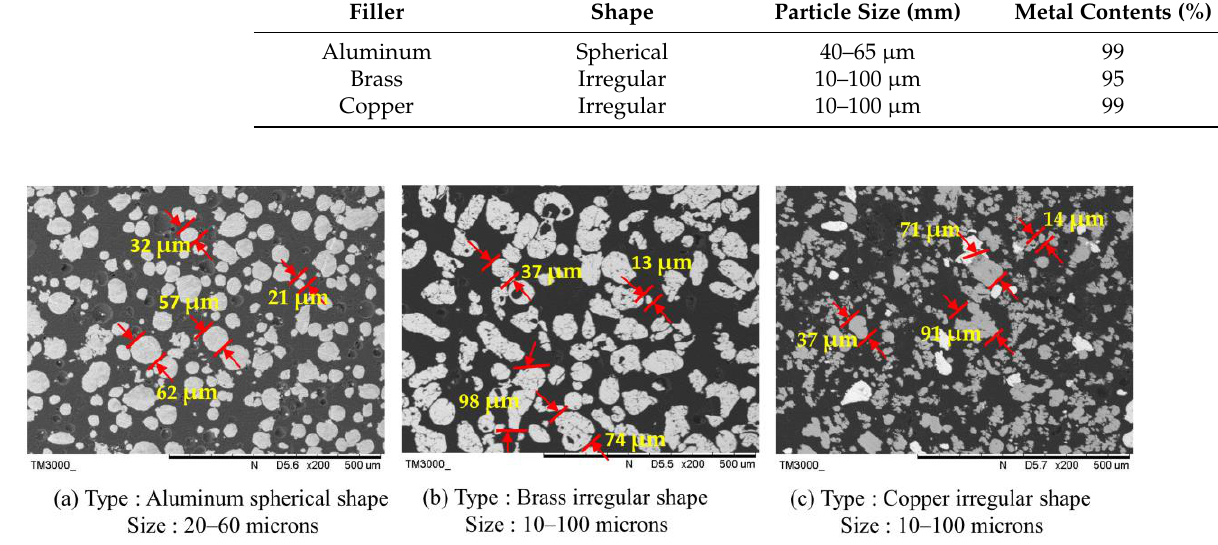
Figure 3. Particle size and shape.